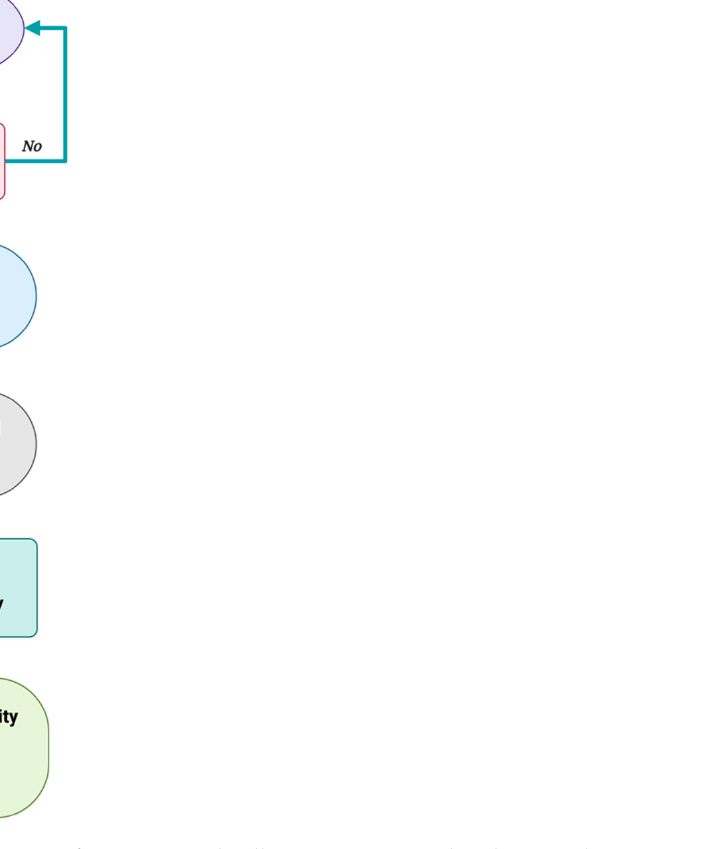
Figure 1. Data flow diagram of SEMiNExt. The illustration is created with Figure 1 . Data flow diagram of SEMiNExt. The illustration is created with Biorender.com.